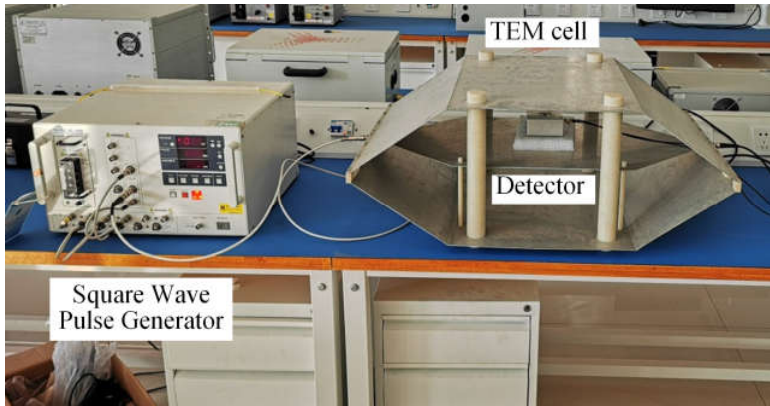
Figure 8. Scenario of detector calibration.